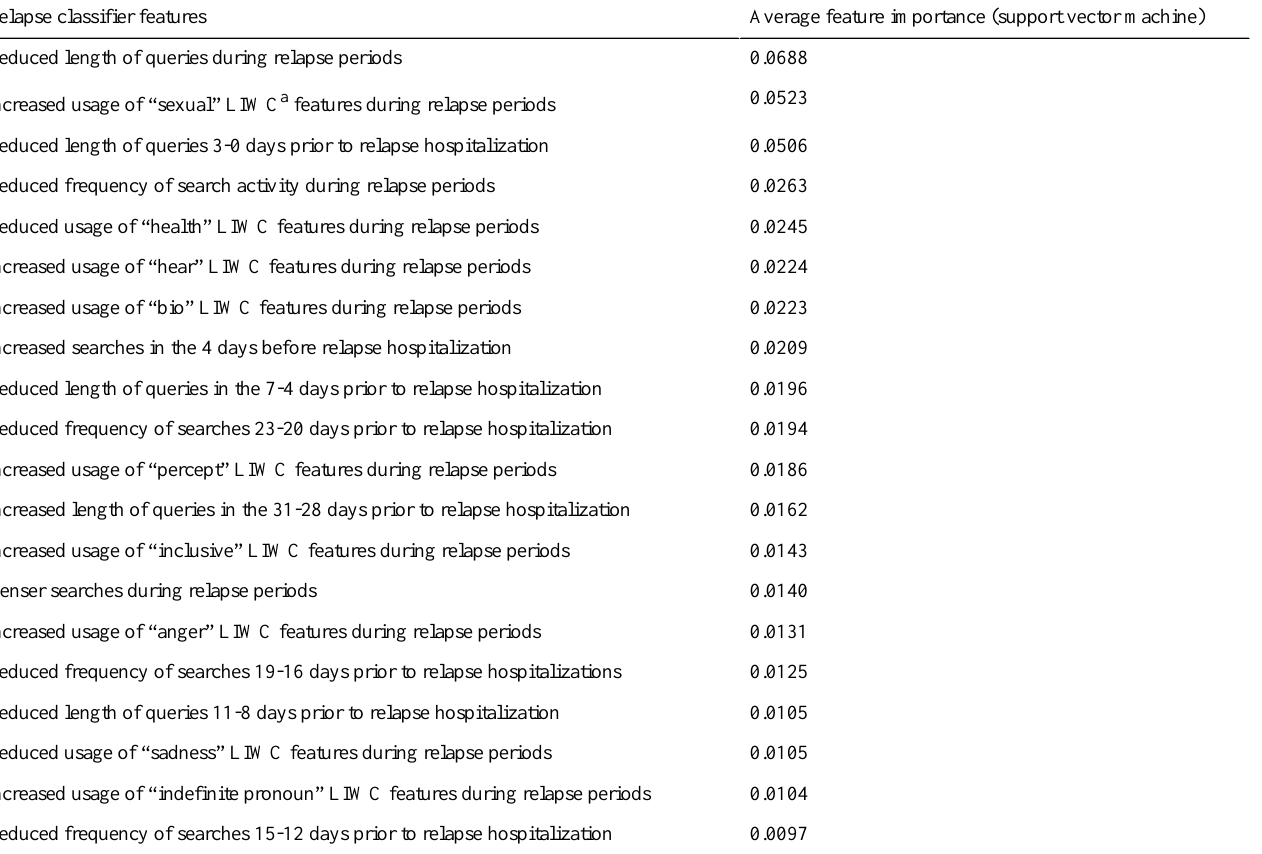
Table 8. Feature importance of relapse classifiers sorted by decreasing order of importance.